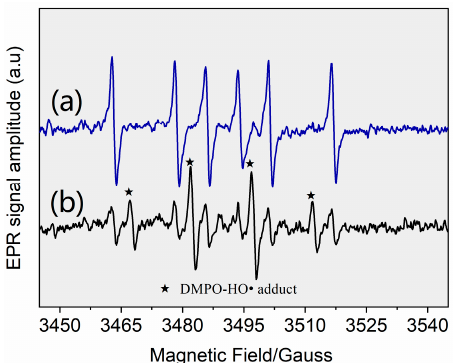
Figure 3. Derivative electron paramagnetic resonance (EPR) spectra of samples collected from ( a ) control blank (1 g · L − 1 DMPO solution) and ( b ) UV/FC system ([AHTN] 0 = 1.0 mg · L − 1 ; [FC] 0 = 3.28 mg · L − 1 ; pH = 7.0; and 25 ± 1 °C).